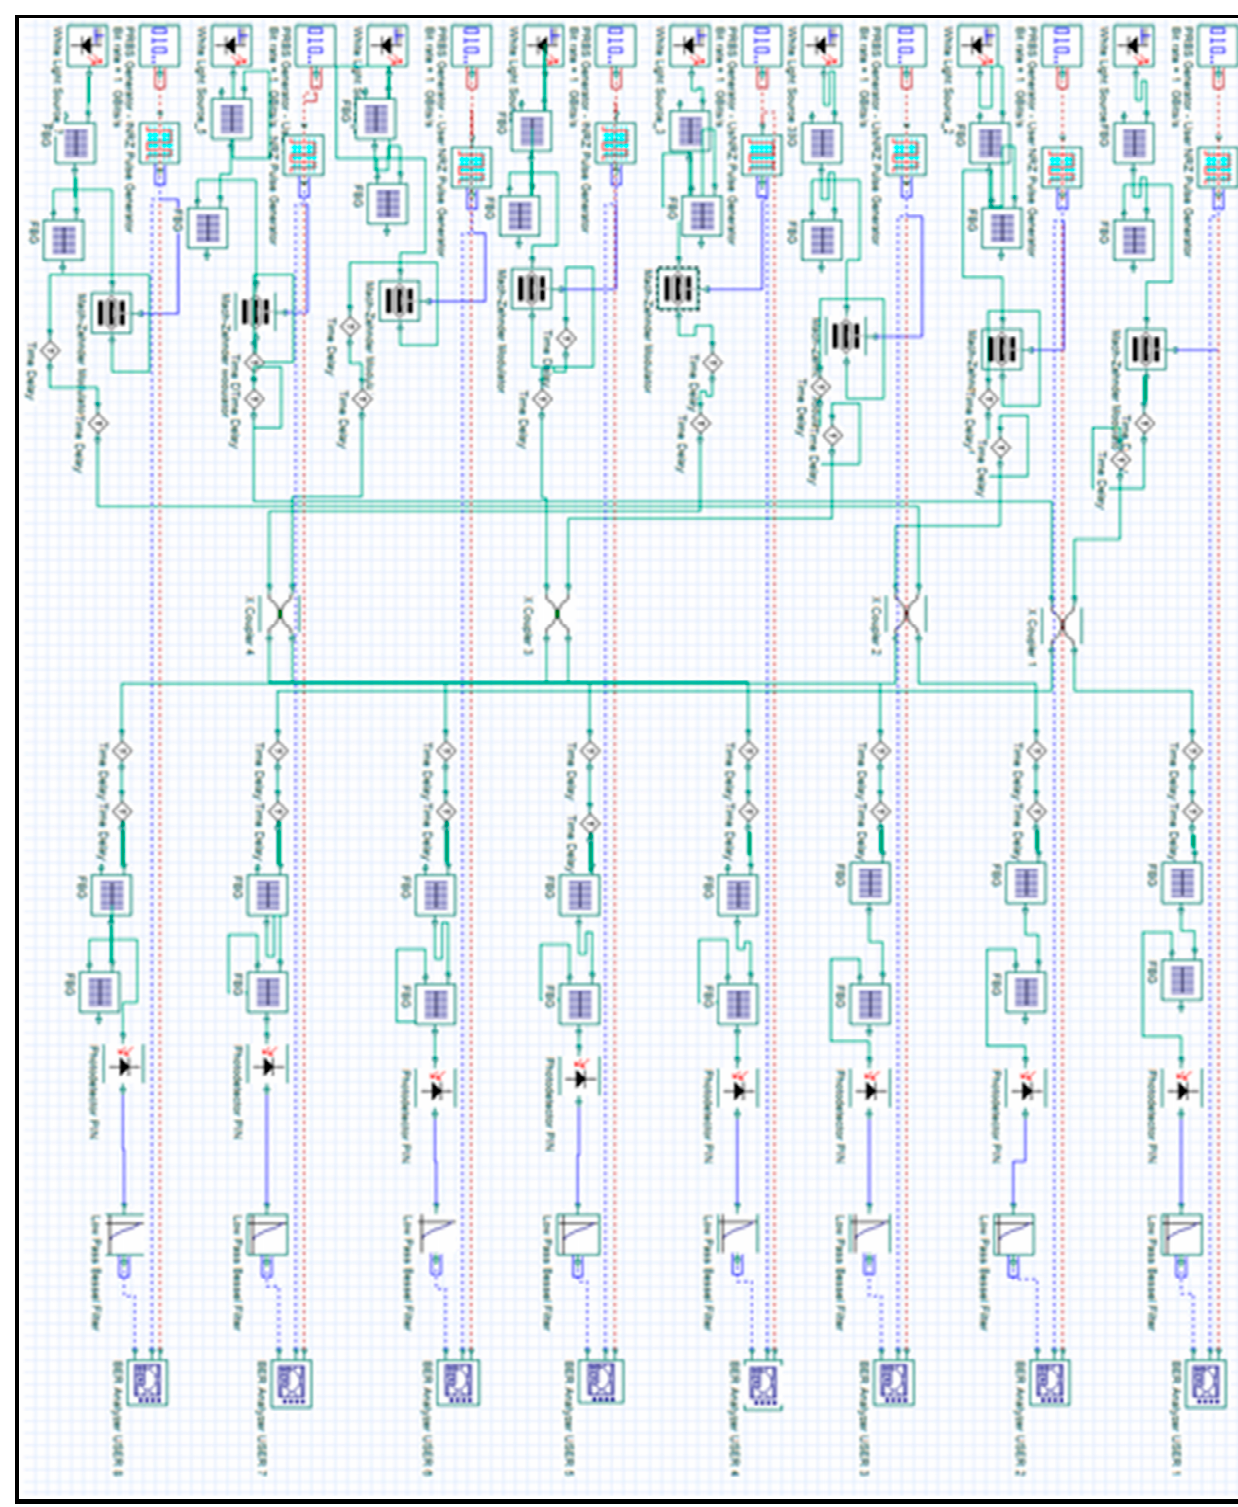
Figure 15. Diagram block of the 3D-VWZCC/OCDMA system. Table 7. Implemented code words for network simulation.